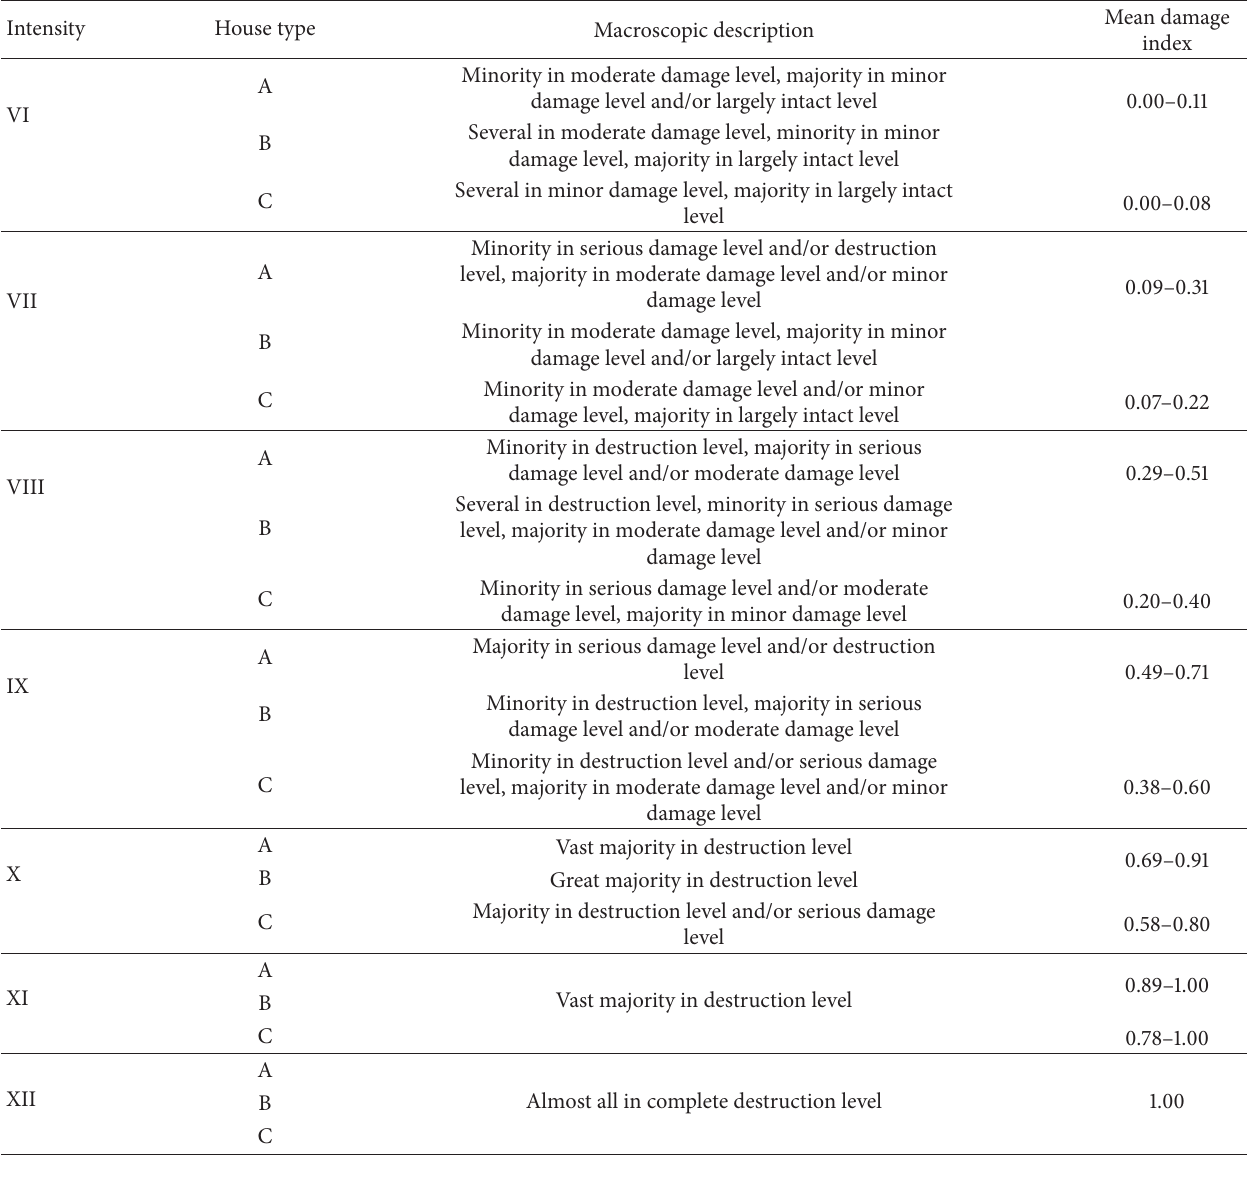
Table 6: Macroscopic description of intensity level and corresponding damage index.